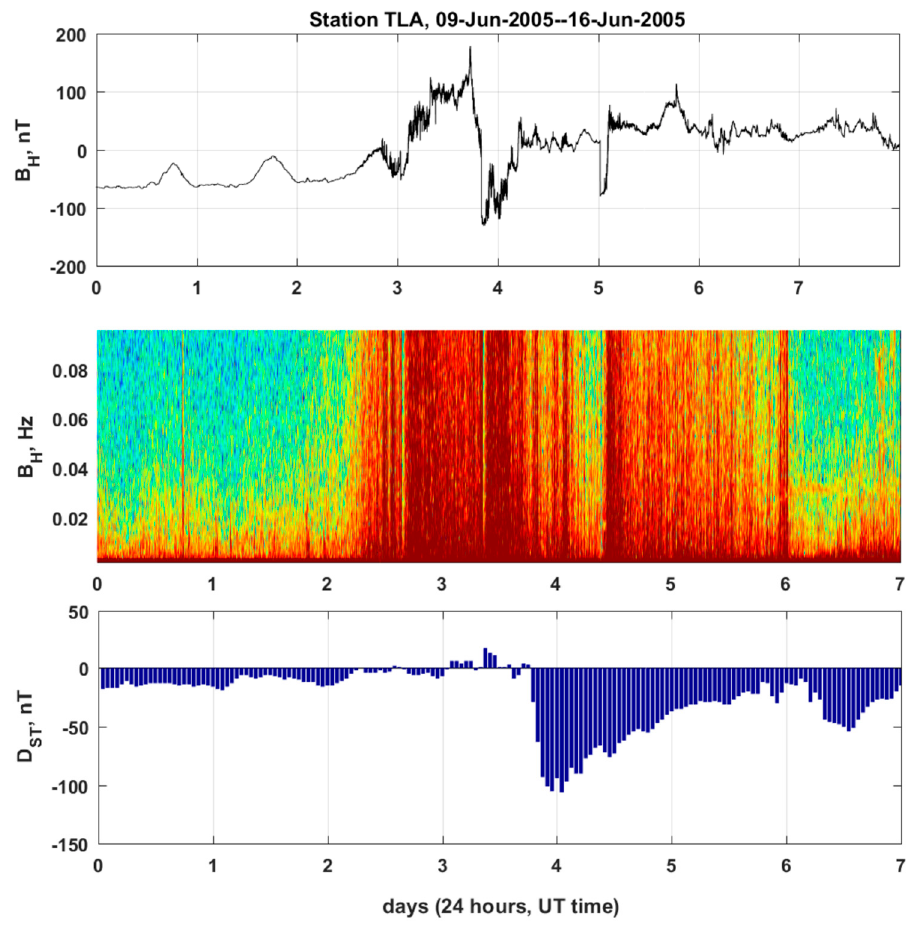
Figure 3. ( top panel ) H—component signal, Tlamacas station. ( middle panel ) Its dynamic spectra. ( bottom panel ) Disturbance Storm Time (Dst) index of geomagnetic activity.